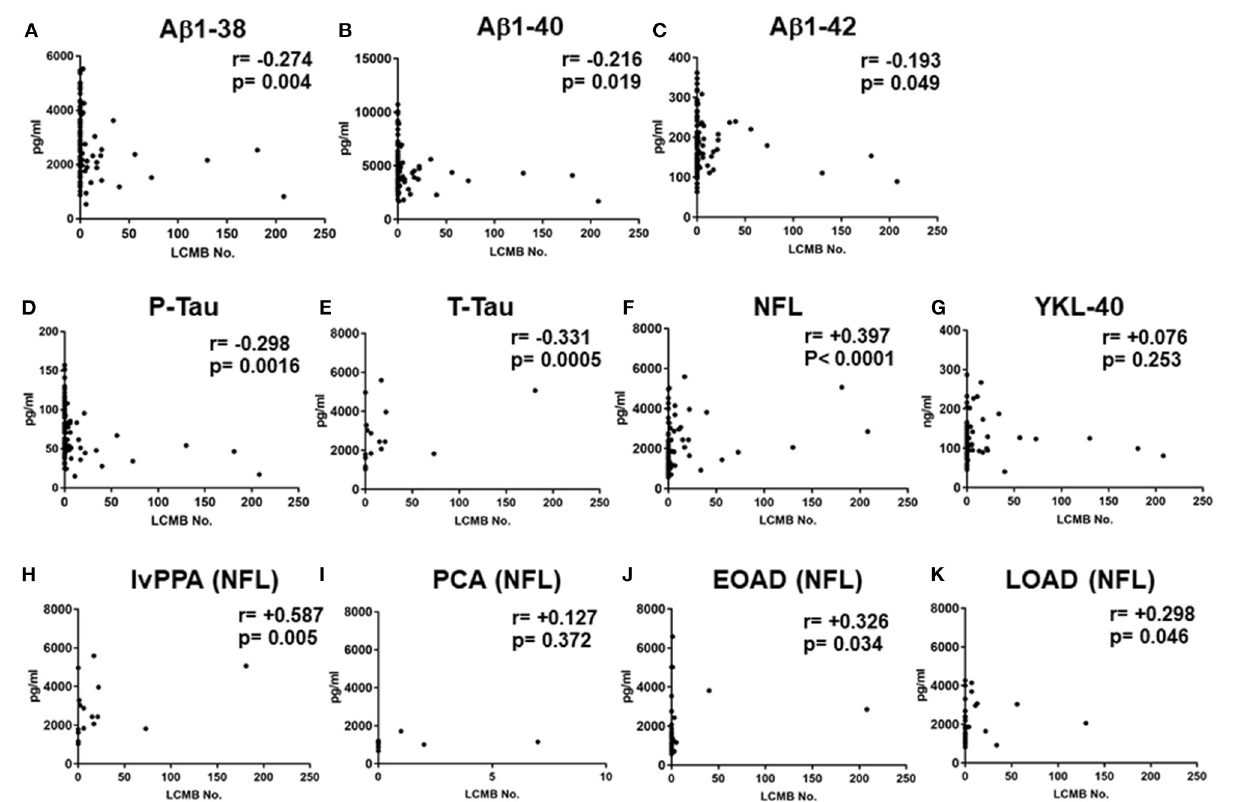
FIGURE 3 | Correlations between the number of lobar cerebral microbleeds, and cerebrospinal fluid levels of A β 1-38, A β 1-40 A β 1-42, P-Tau, T-Tau, NFL, and YKL-40 in the total AD subtypes, and CSF NFL in the lvPPA. Scatter plots presenting the correlations per patient between total number of lobar CMBs and CSF biomarkers,